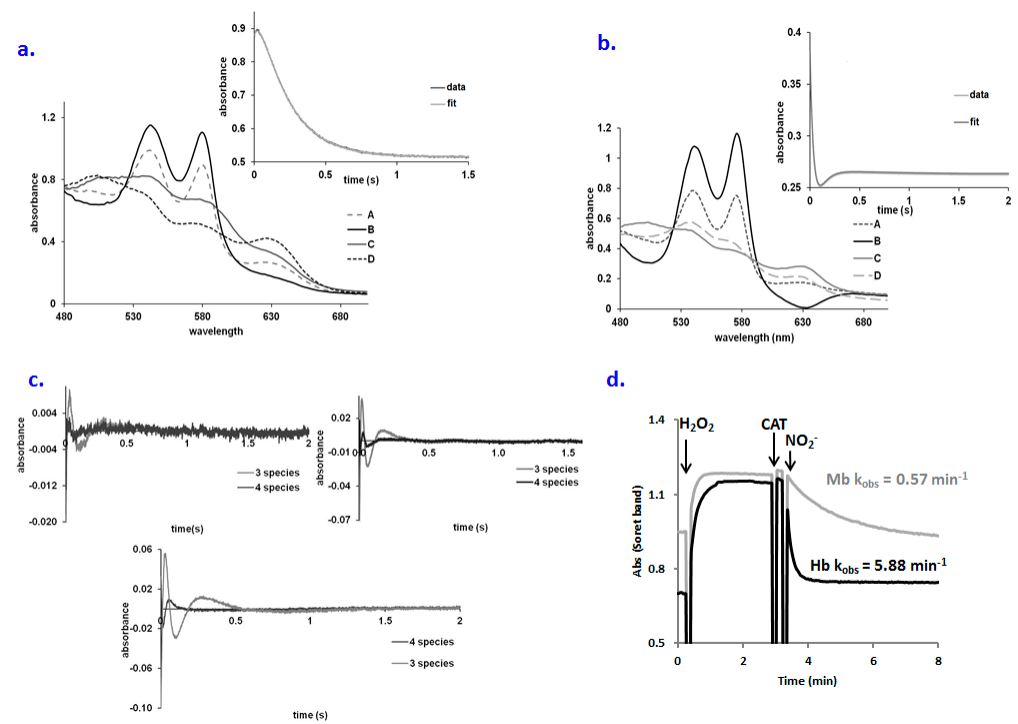
Figure 3. ( a ) Computed spectra for the species involved in the A → B → C → D reaction model for oxyMb + nitrite (A—oxyMb, B—Fe(II)-peroxynitrate, C—metMb, D—met-nitriteMb). Conditions: 75 µ M Mb, 0.5 M pH 7.4, PBS buffer, aerobic. Inset: fitting at 575 nm trace for the A → B → C → D kinetic model; ( b ) Computed spectra for the species involved in the A → B → C → D reaction model for oxyMb + nitrite (A—oxyMb, B—Fe(II)-peroxynitrate, C—metMb, D—met-nitriteMb). Conditions: 75 µ M Mb, 0.5 M pH 7.4, PBS buffer, aerobic. Inset: fitting at 575 nm trace for the A → B → C → D kinetic model; ( c ) Residual plots of the A → B → C kinetic model vs. A → B → C → D kinetic model for the: left panel: oxy Mb + nitrite, right panel: oxyHb +nitrite, lower panel: oxyHb-guanidine + nitrite. Conditions cf. Materials and Methods; ( d ) Ferryl formation from the met form and its reduction with nitrite for both Mb and Hb (8 µ M protein, 100 µ M hydrogen peroxide, 0.3 µ M catalase (CAT) for excess of peroxide removal, 0.3 mM nitrite, PBS buffer pH